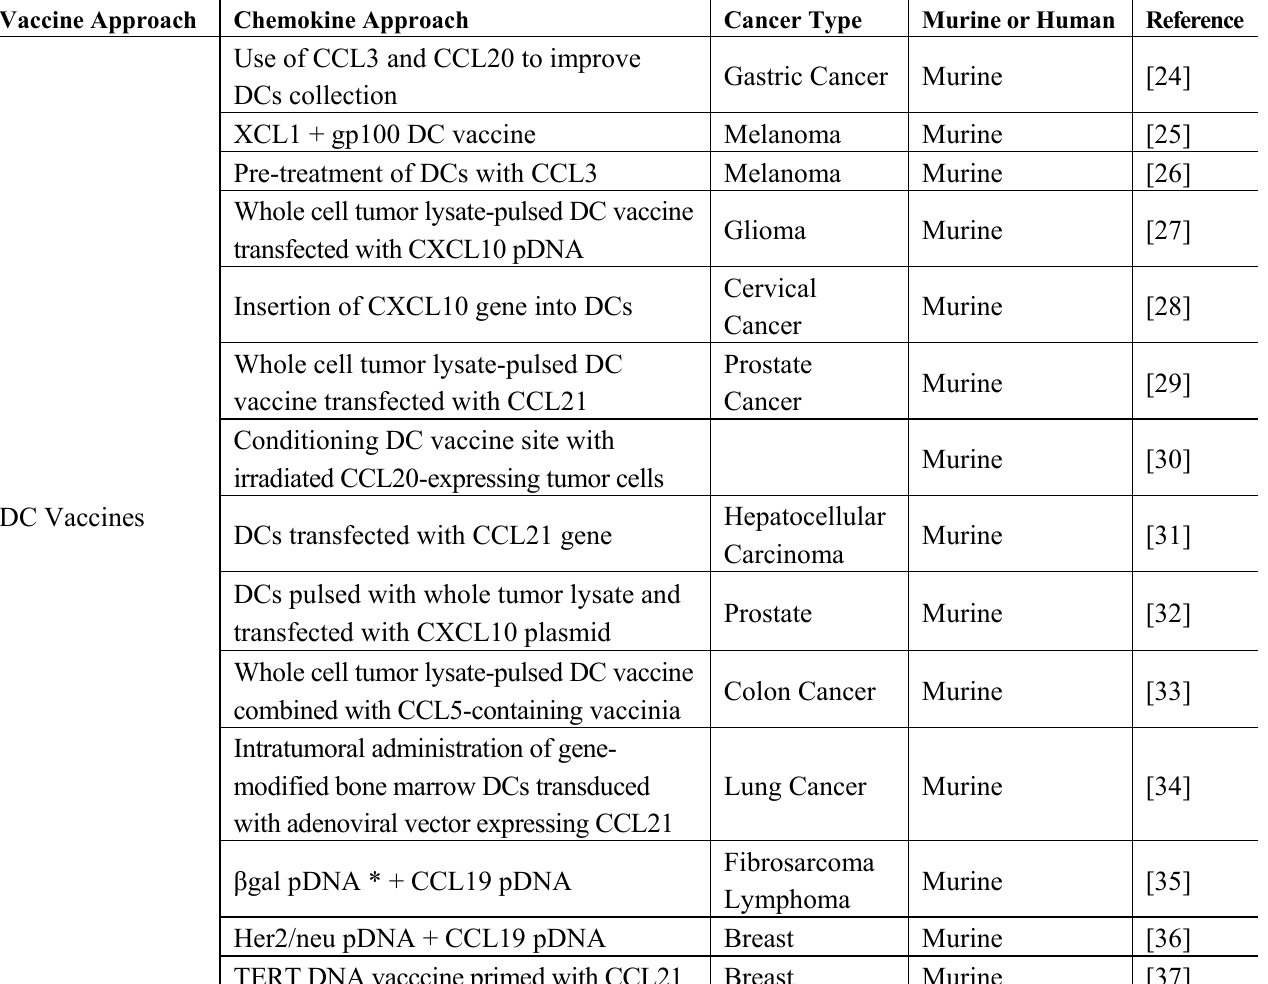
Table 2. Vaccine approaches incorporating various